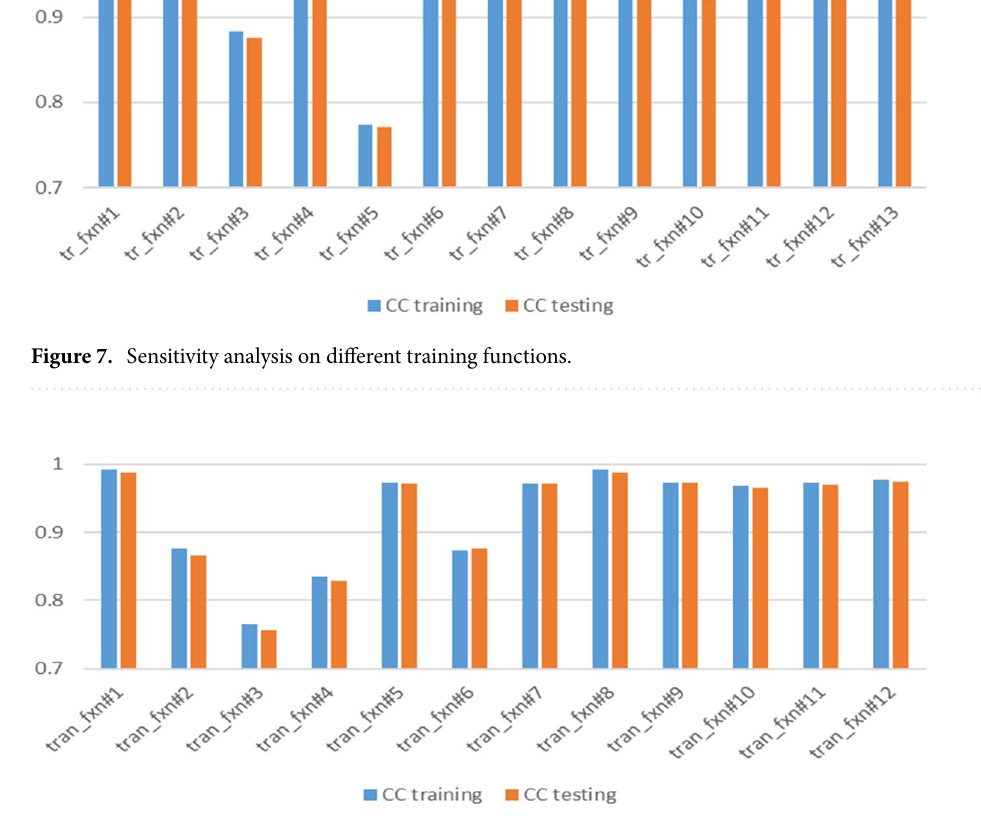
Figure 8. Sensitivity analysis of different transfer